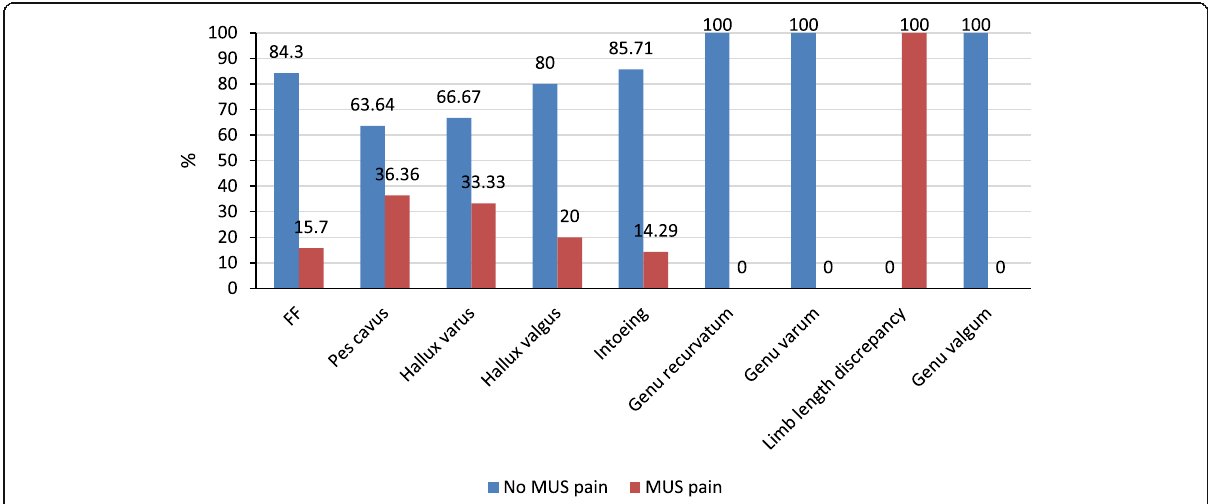
Fig. 1 Relations between musculoskeletal (MUS) pain and lower limb deformities among the studied children